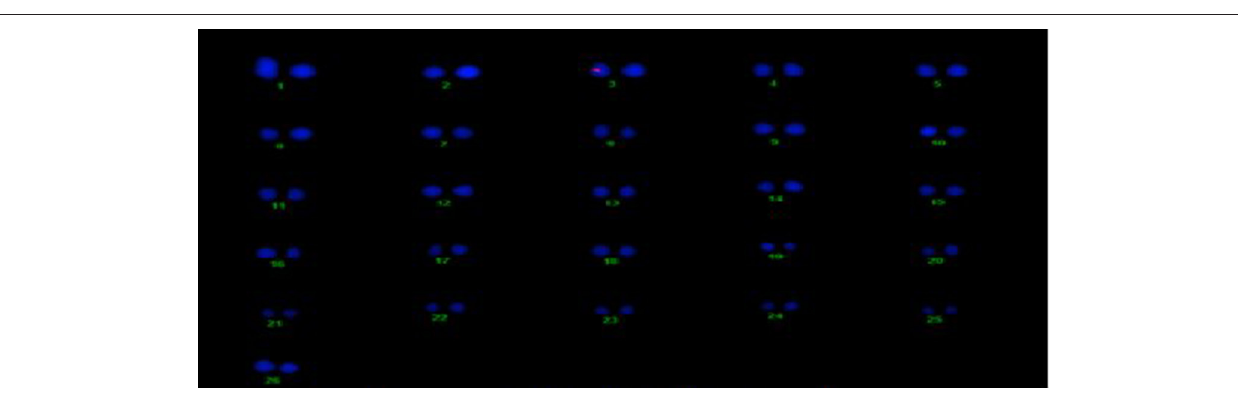
FIGURE 13 | Determination of GT-Gene transgene location on cotton